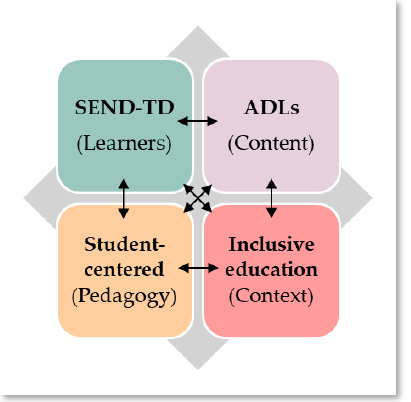
Figure 4. The four-dimensional dynamic system of interactivity.